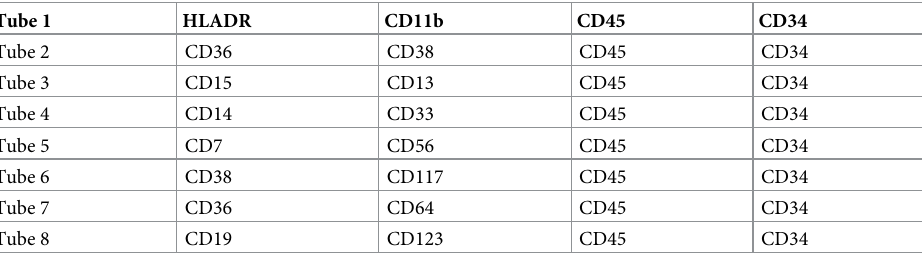
Table 1. Flow cytometry markers per